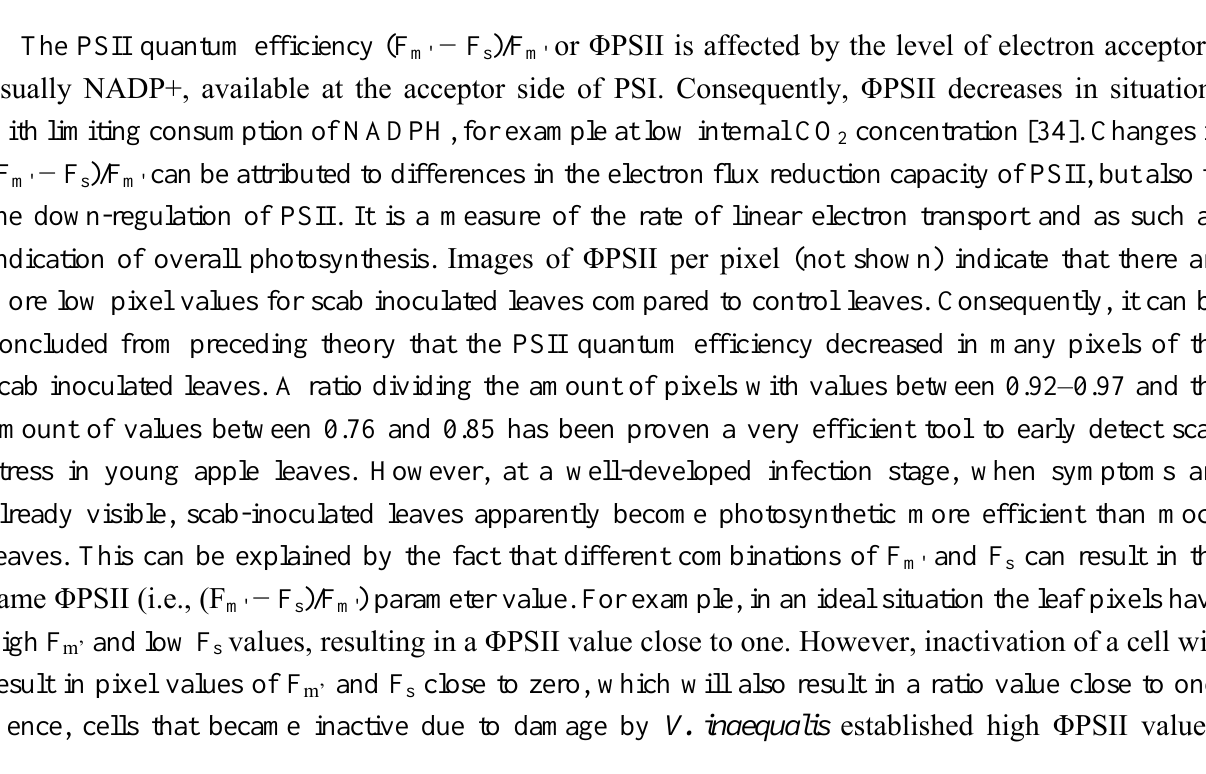
/R for each 1480 2135